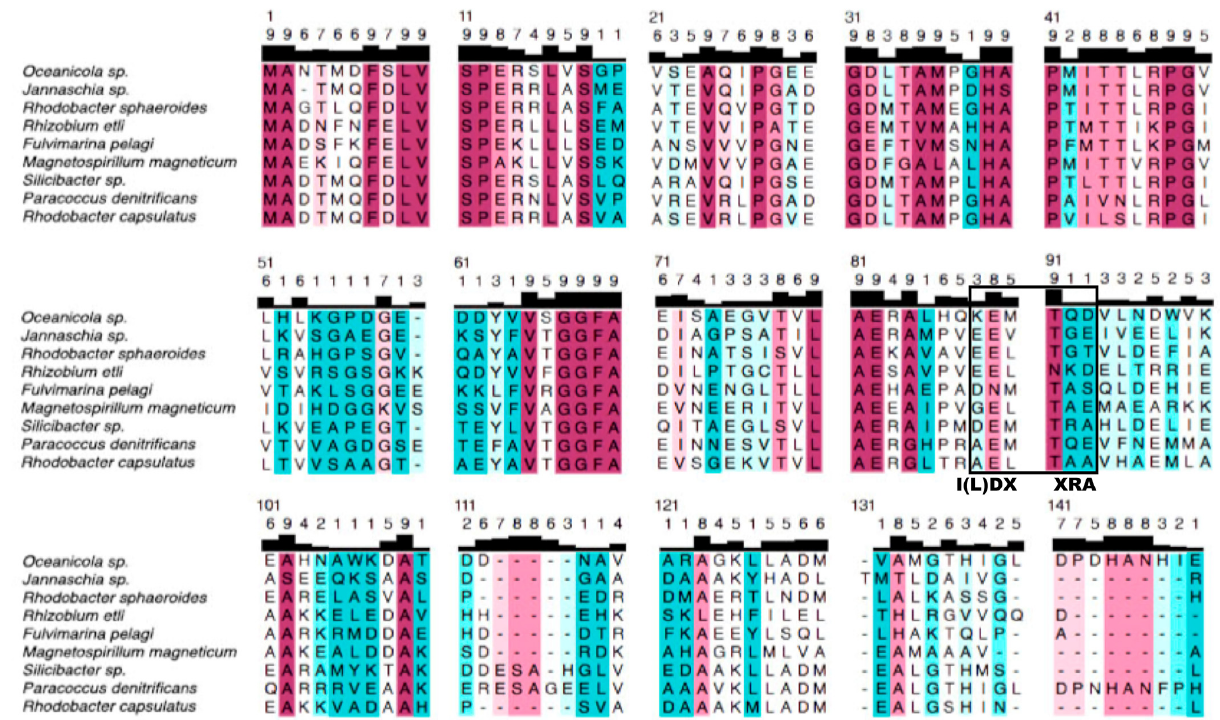
Figure 2. Alignment of the ε subunits of the α -protebacterial ATP synthase. The sequences shown were aligned with Clustal Omega, and the alignment was visualized in UCSF Chimera. Color codes: cherry red: strongly conserved residues; pink, conserved residues; light pink, less conserved residues; , slightly variable residues; light blue, variable residues; pale blue, average variable residues; strong blue, strongly variable residues. The most conserved region of the Pd- ε subunit is in the N-terminal side, the function of which is structurally connecting the γ subunit of F 1 with the c 12 ring of F O ; see the case of the P. denitrificans F-ATP synthase in Figure 1C. The Pd- ε subunit is the largest one of this alignment, even larger than that of Oceanicola sp. with addi- tional 9 a.a.s at the C-terminus. The C-terminus of α -proteobacterial ε subunit is highly variable, and this divergence leads to the loss of the ATP-binding motif of other bacterial inhibitory ε subu- nits (I(L)DXXRA) (see black box). The divergence of the C-termini of the α -proteobacterial ε subu- nits very likely produces the loss of both the inhibitory function of the two C-terminal α -helical hairpin domains and the loss of the regulatory ATP-sensor-binding motif. See text for further de- tails.